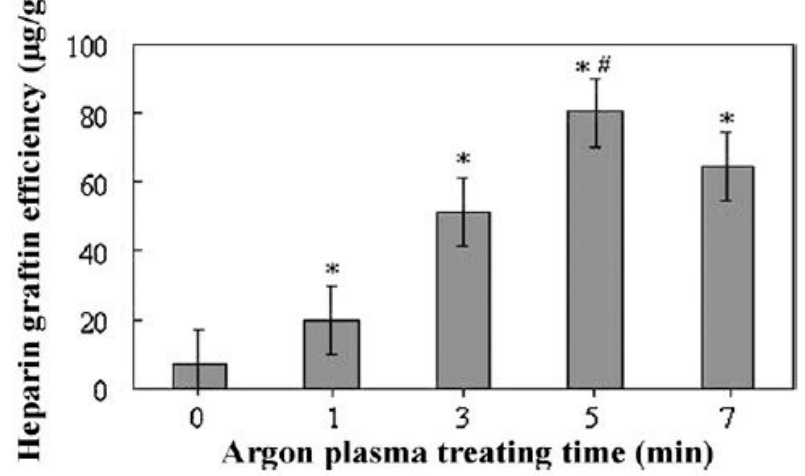
Figure 22. Grafting performance of heparin to silk fibroin scaffolds as a function of Ar plasma treatment time (* p < 0.05, significant different between the grafting efficiency of plasma-treated scaffolds and untreated scaffolds; # p < 0.05, significant different between the performance at an Ar plasma exposure time of 5 min compared to an Ar plasma exposure time of 1, 3 and 7 min)—reproduced with permission from [273]. Copyright Elsevier, 2011.